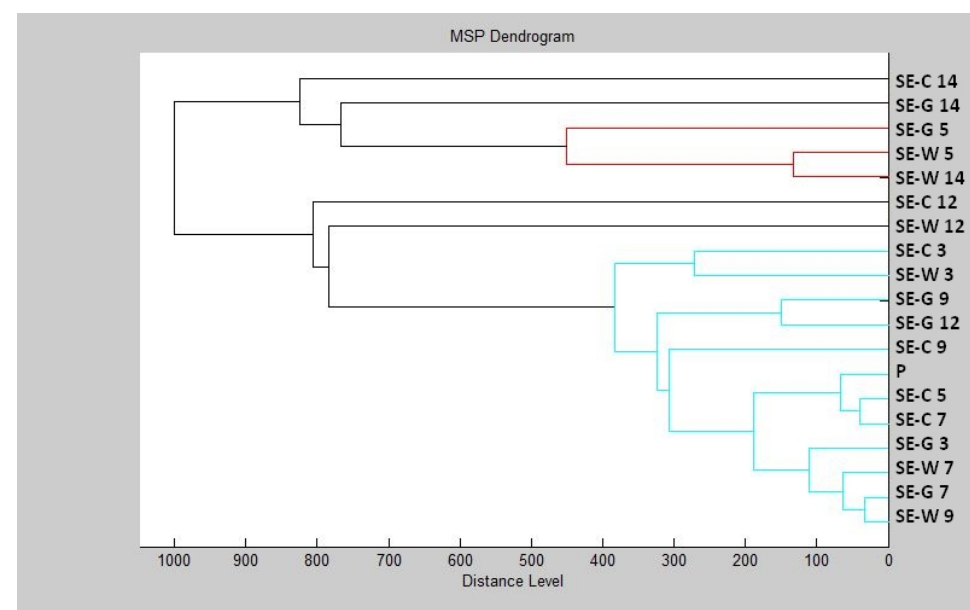
Figure 4. Dendrogram of S. enterica biofilm progress after TTEO exposition. SE— S. enterica ; C—control; G—glass; W—wood; P—planktonic cells.